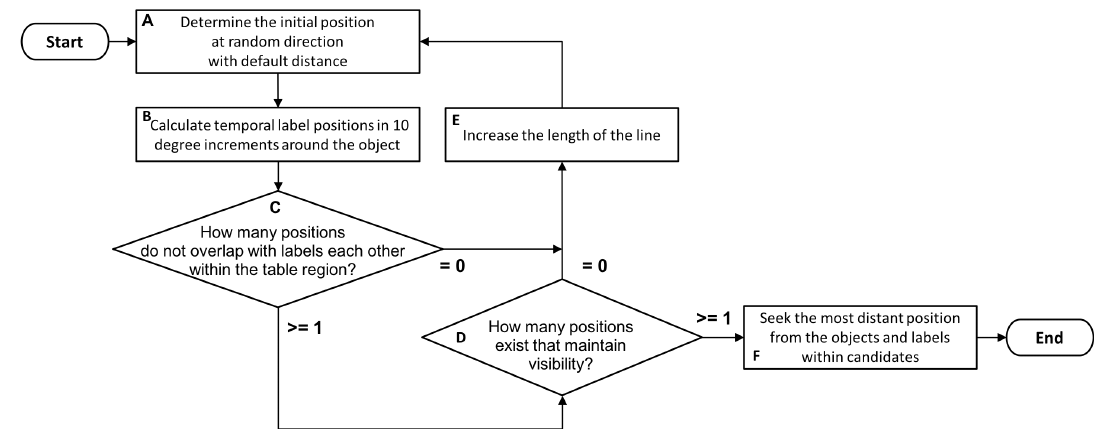
Figure 1. Processing flow of the VisLP algorithm.